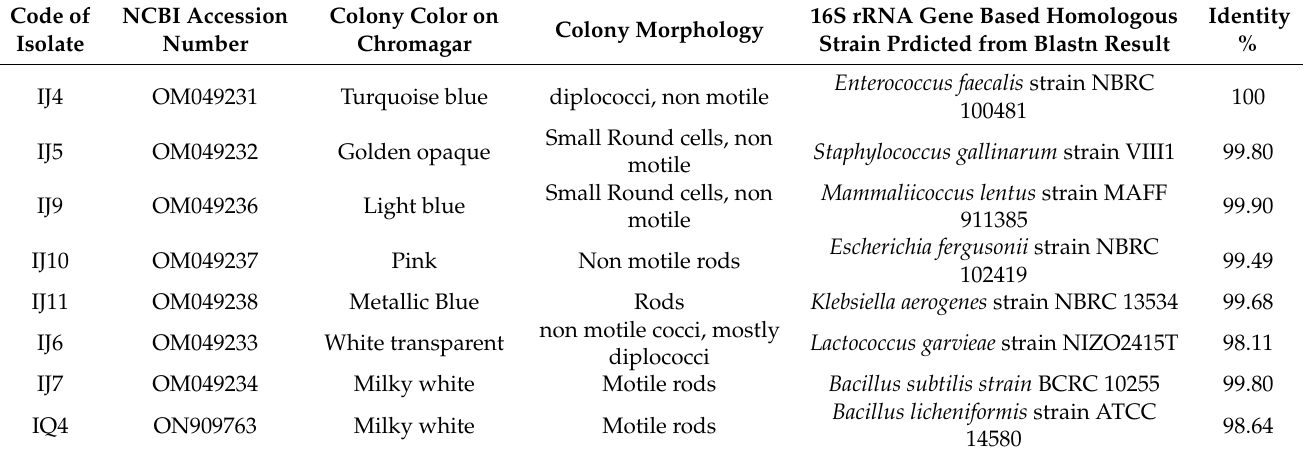
Figure 5. Phylogenetic tree showing the clustering of intestinal bacteria grown on MRS plates on the basis of 16S rRNA gene sequences with their closely related homologs. The phylogenetic relationship was inferred using the neighbor-joining method by MEGA11 software program. The bootstrap consensus tree was inferred from 100 replicates. Table 3. List and 16S rRNA gene sequence-based identification of bacterial isolates from mice intestine obtained on CHROMagar and MRS ‐ agar media.